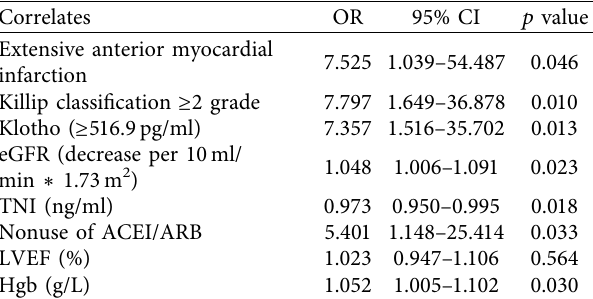
Table 4: Te binary logistic regression model for predicting AKI in AMI